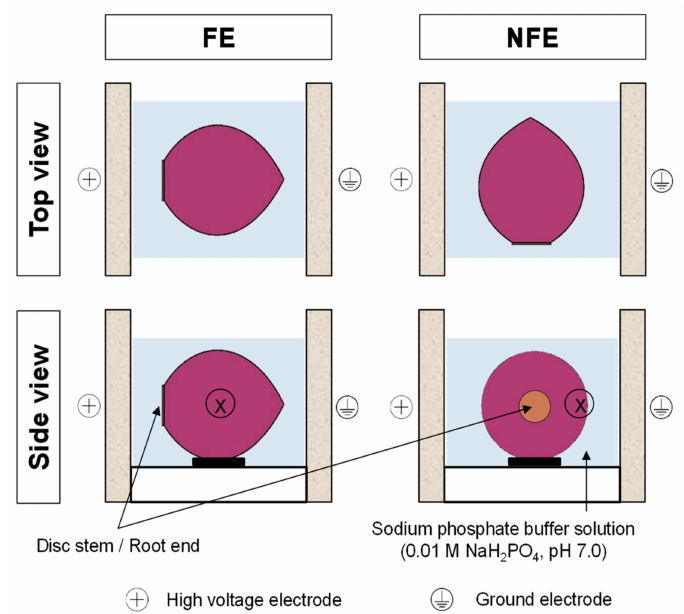
Figure 1. Schematic structure of an onion bulb.